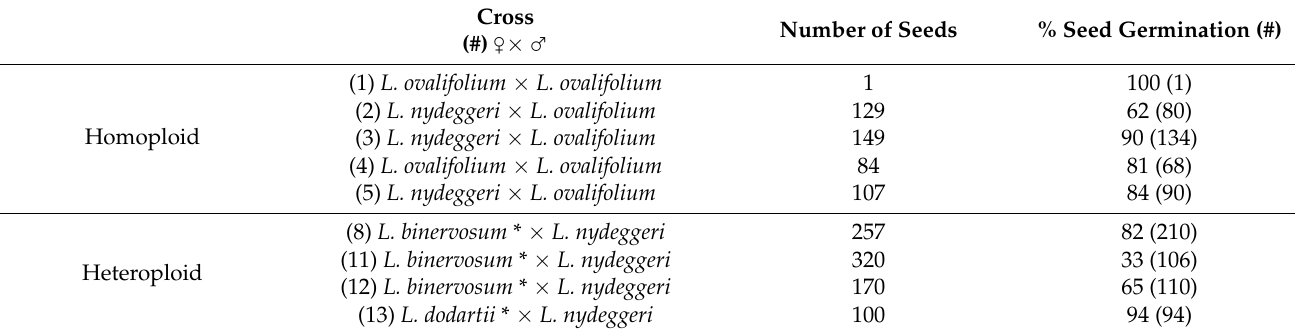
Table 5. Percent of seedlings with certain morphotypes and polyembryony from open cross-pollination experiment of plants originated in homoploid (diploid × diploid) and heteroploid (tetraploid × diploid) crosses. The data on species and on experimental crosses were derived from [4]. The species marked with an asterisk (*) reproduce by apomixis [4]. The number given in parentheses represents the number of seedlings. Symbols: